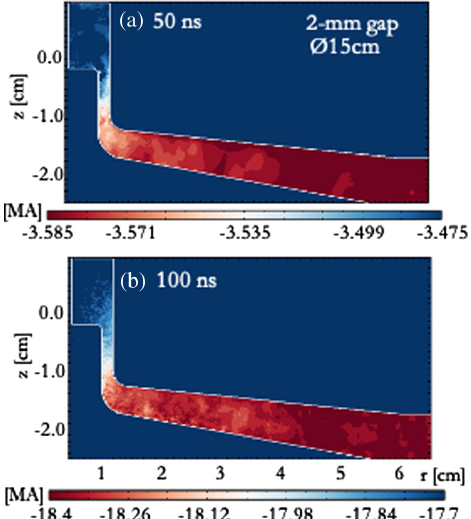
FIG. 13. Current distribution in the ∅ 15 cm 6-mm gap sim- ulation [Fig. 8(d)] at (a) 50 ns and (b) 100